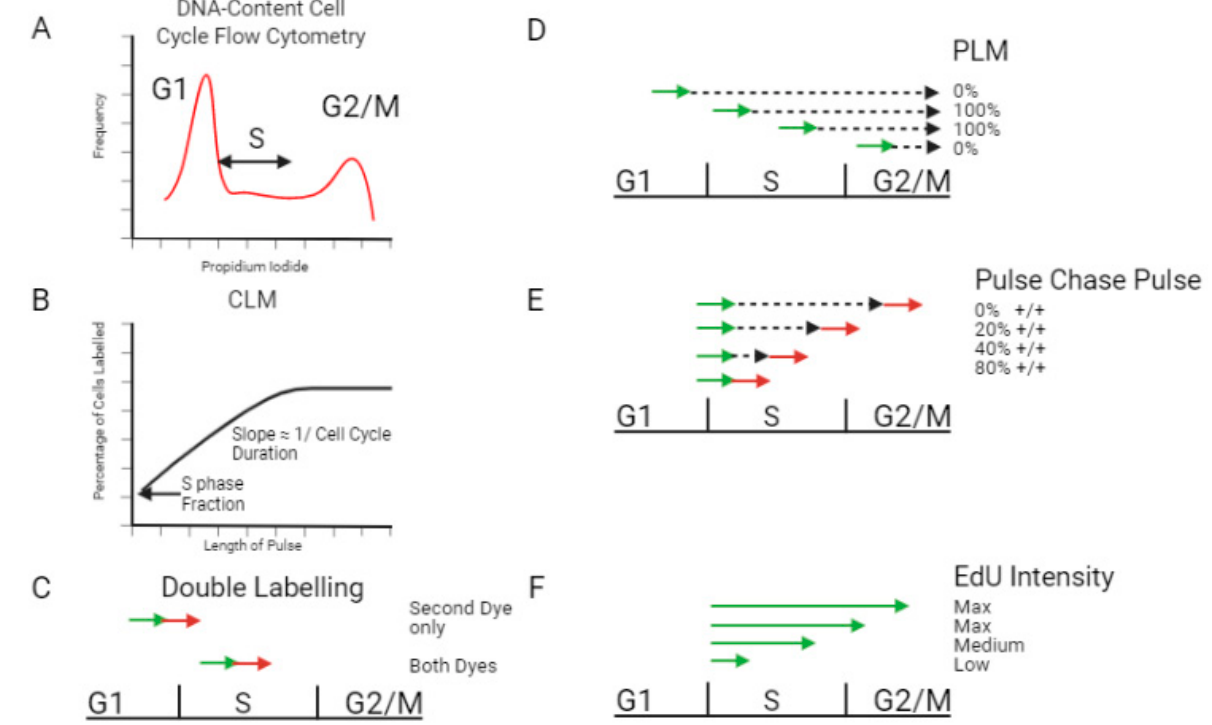
Figure 1. Methods to measure S phase duration in an unsynchronized population. ( A ) Flow Cytometry using a DNA-dye to Quantify the Amount of DNA Present. This allows the percentage of cells in S phase to be calculated. ( B ) Cumulative Labeling method. Cells are exposed to increasing pulses of labelled nucleotides. When 100% of cells are labelled, it can be deduced that the pulse length was equal to the duration of G1+G2+M. An approximation for the slope can be calculated following reference [14]. ( C ) Double Labeling. The proportion of cells labelled only with the second dye indicates rate of exit from S phase. ( D ) Percentage Labelled Mitosis. Cells are exposed to a short pulse of labelled nucleotides (green arrow) and then increasing chases (black dashed arrow). The percentage of mitotic cells containing labelled nucleotides is tracked over time. ( E ) Pulse Chase Pulse. Cells are exposed to short pulses of different colors (green and red arrows), with increasing chases in between (black dashed arrow). The percentage of S phase cells labelled with both dyes is shown ( F ) EdU Intensity. Cells are exposed to increasing pulses of EdU (green arrow). When maximal intensity is reached it indicates that a population of cells have been exposed to EdU for the entire length of S phase. Figure created with Biorender.com, accessed on 5 April 2022.